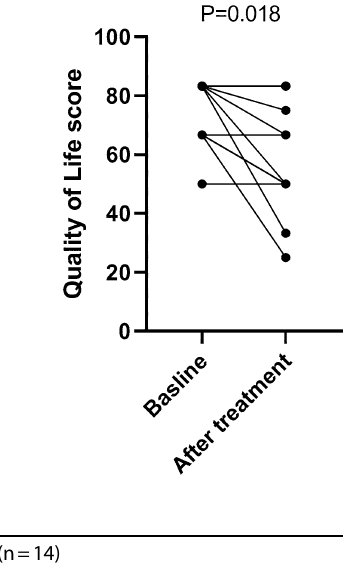
Table 7 > 10% of patients Adverse event, n (%) Any TRAEs (n = with adverse events